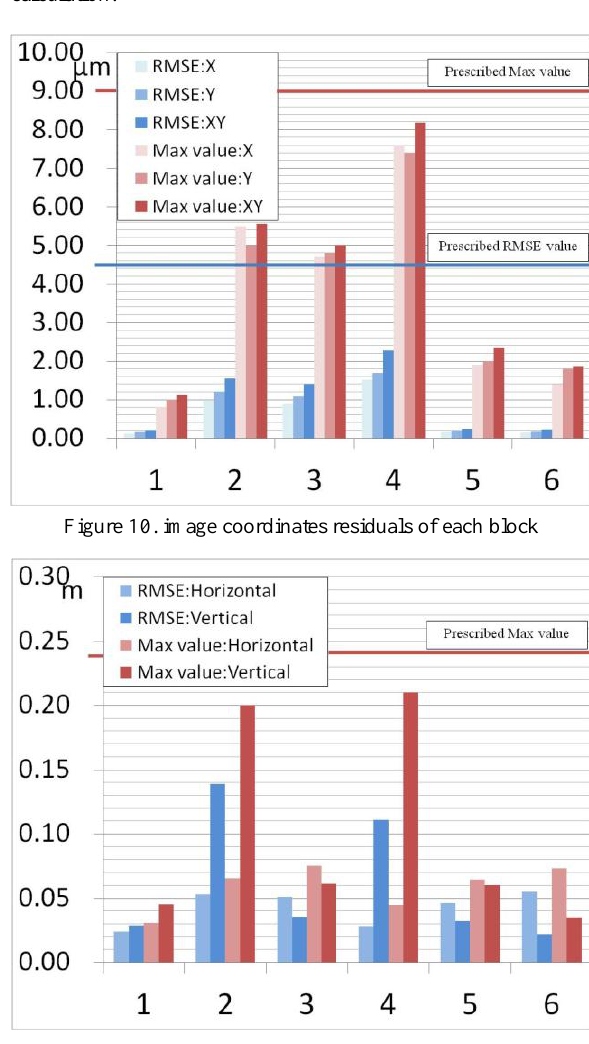
Figure 11. Control point residuals of each block